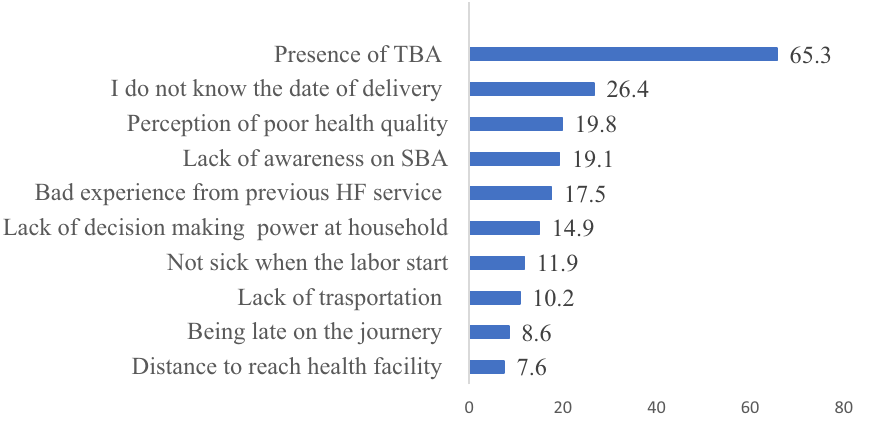
Figure 3. Reasons for preferring home delivery in Northwest